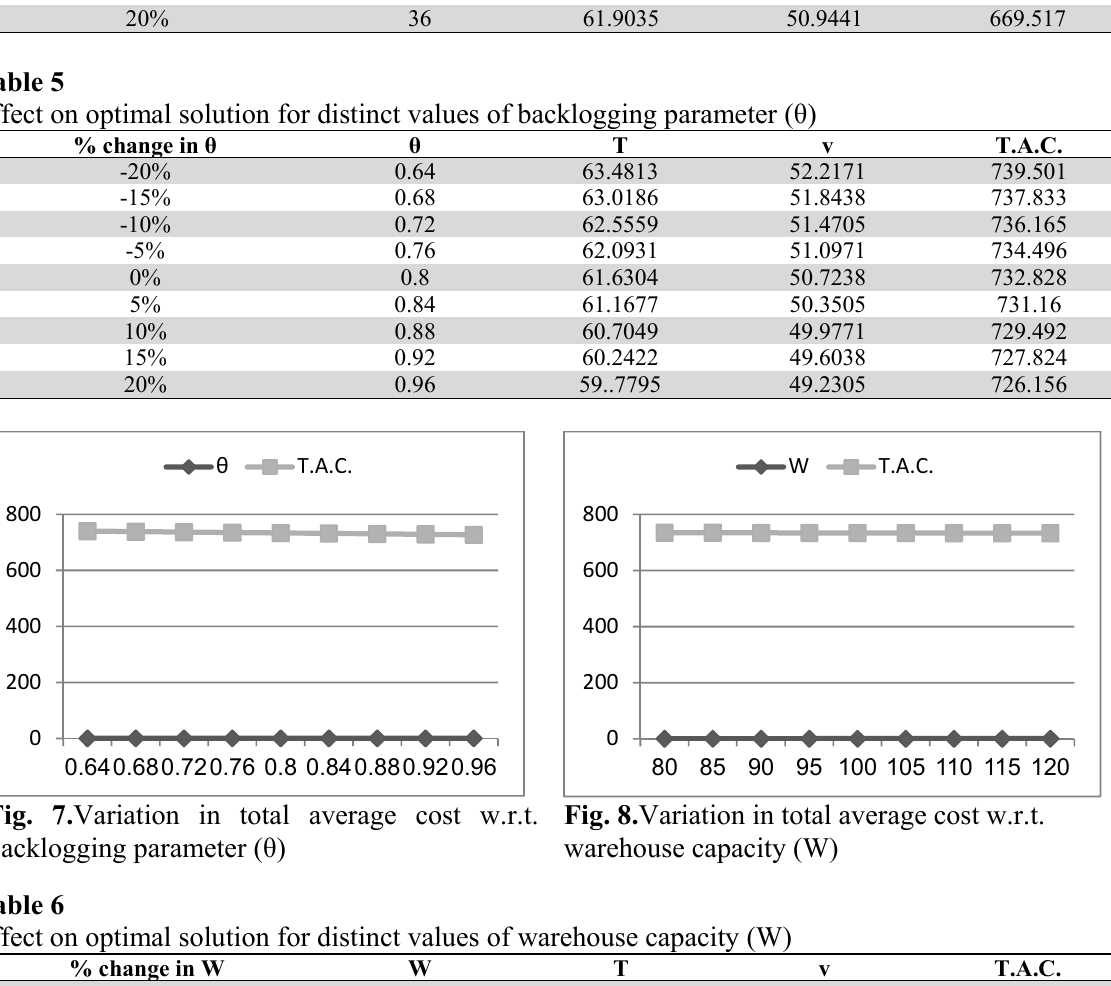
Effect on optimal solution for distinct values of backlogging parameter ( θ ) % change in θ